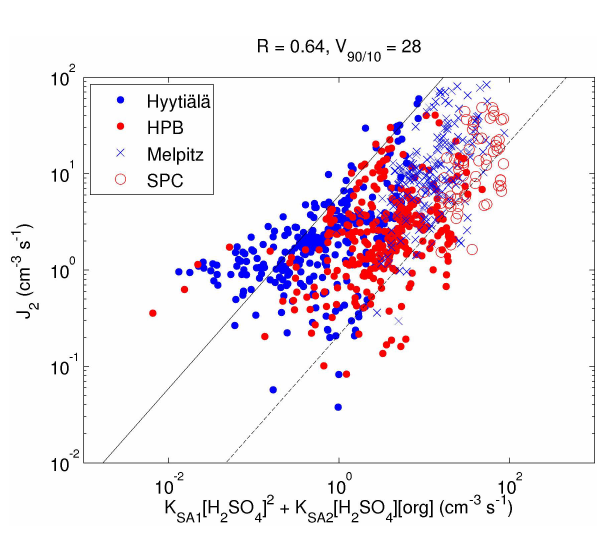
Fig. 8. Neutral particle formation rate J 2 as a function of the sum of sulphuric acid and low-volatility organic vapour concentrations multiplied with separate nucleation coefficients A s1 =5.8 × 10 − 7 and A s2 =5.4 × 10 − 8 s − 1 . The lines present the 90th (solid) and 10th (dashed) percentile values of the ratio between the observed J 2 and the rate modelled with Eq. (18).